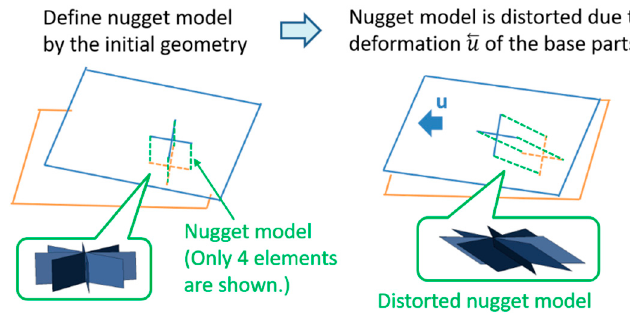
Figure 17. Distortion of the nugget model.